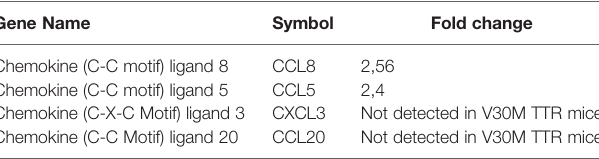
TABLE 1 | Chemokines found downregulated in V30M sciatic nerve compared with sciatic nerve from WT mice.